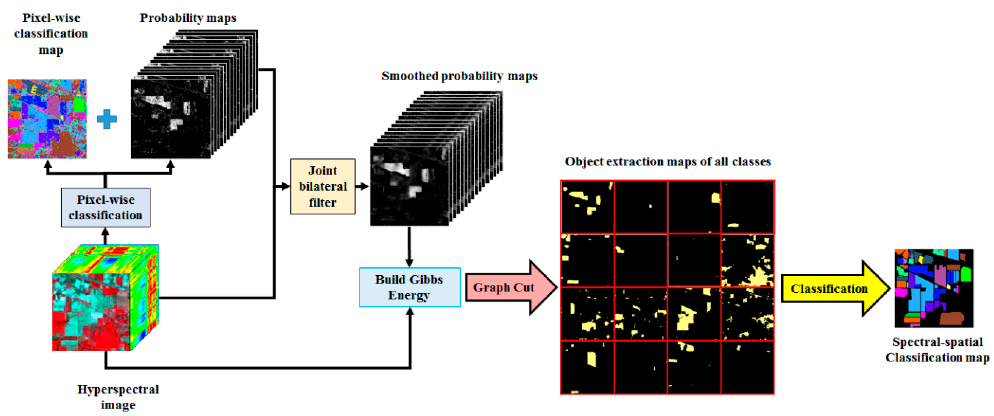
Figure 1. Illustration of the proposed spectral-spatial classification method.